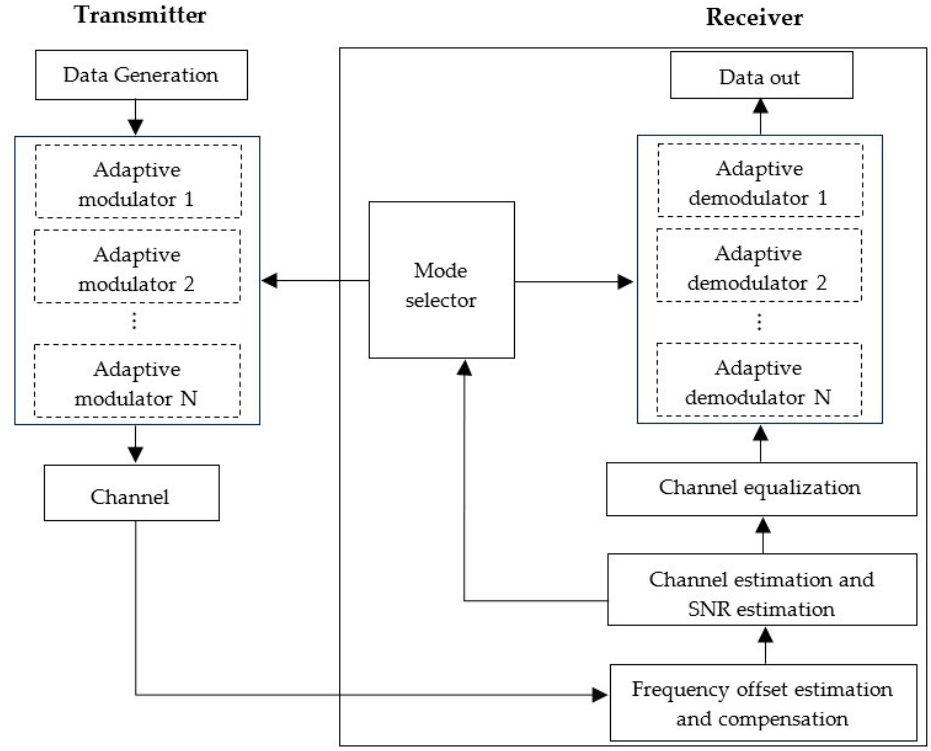
Figure 2. Block diagram of adaptive modulation scheme.